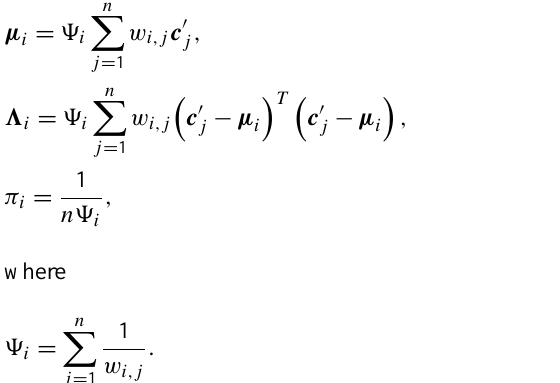
◦ ◦ × 2 horizontal res- 2 3 ◦ ◦ × 2 grid square 2 3